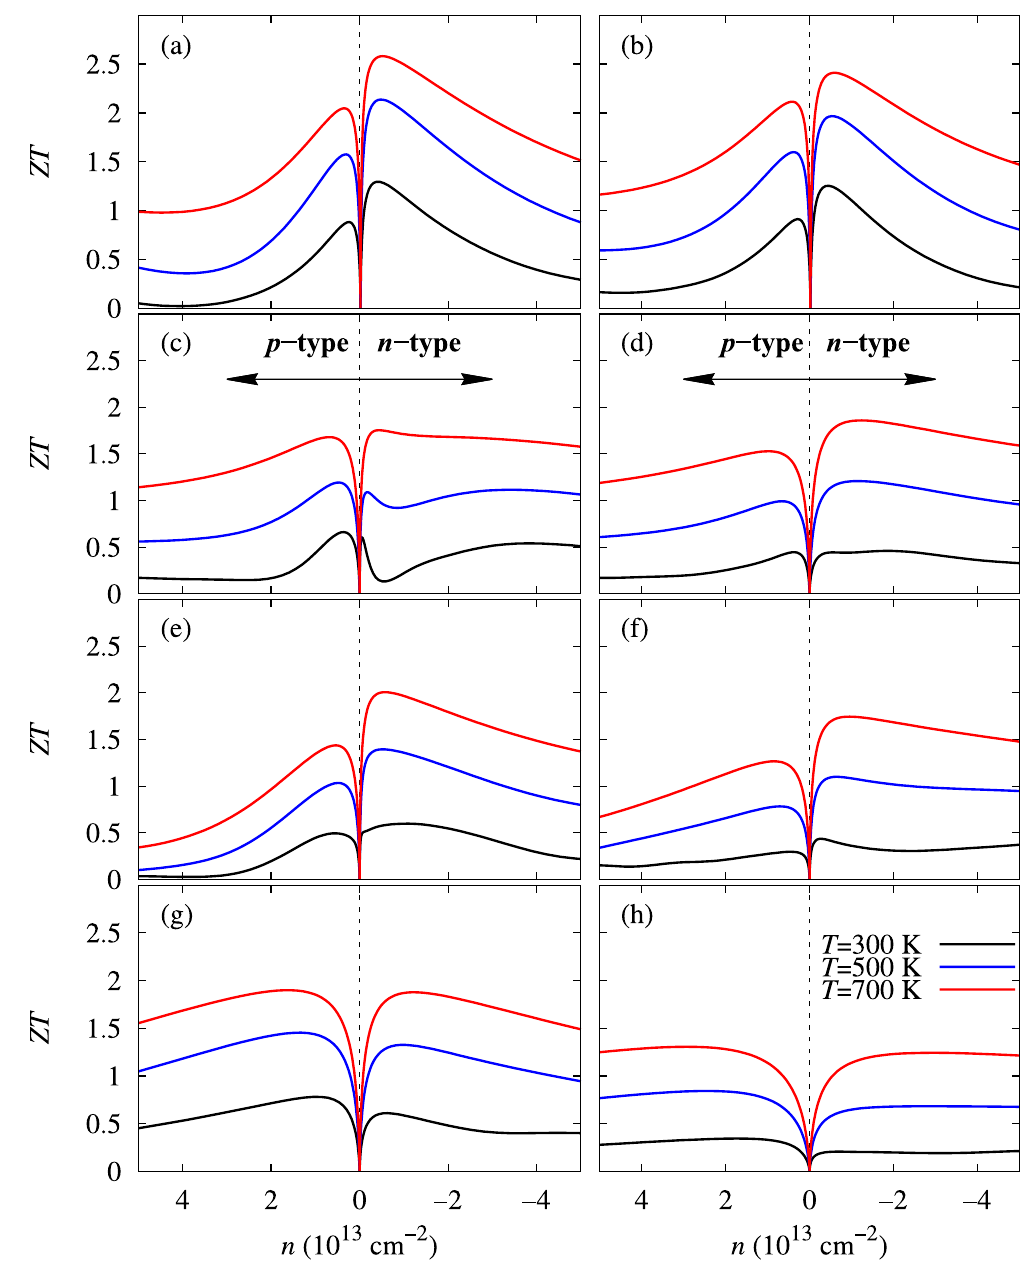
Figure 7. Calculated Figures of merit ( ZT ) as a function of the carrier concentration ( n ) for the monolayer of ( a , b ) SnSe, ( c , d ) SnS, ( e , f ) GeSe, and ( g , h ) GeS along armchair and zigzag directions at temperature 300 K, 500 K, and 700